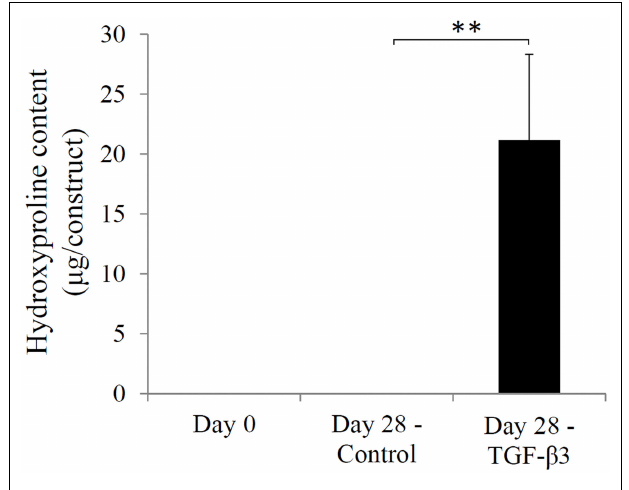
FIGURE 5 | Hydroxyproline levels in hASC-encapsulated VL-PSL-fabricated constructs in the control and TGF- βββ 3 groups at days 0 and 28 . Levels of hydroxyproline in days 0 and 28 control groups were negligible, and levels in the day 28 TGF- β 3 group measured at 21.16 (cid:6) 7.15 μ g/construct. ** p <